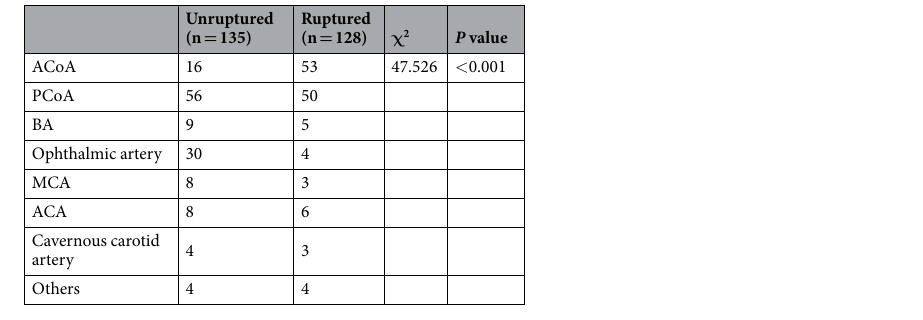
Table 3. Univariate analyses for the locations of the ruptured and unruptured small intracranial aneurysms.